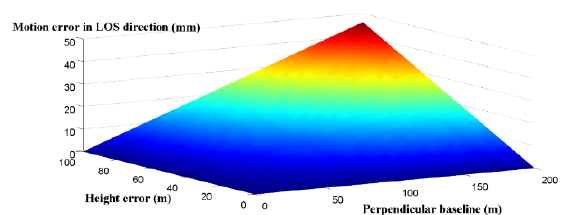
Figure 1. Motion error represented as a function of the perpendicular baseline length and the height error for the case of TSX system For the case of TSX system with the nominal imaging parameters, i.e., q =41 ° , R =662520m, Figure 1 shows the functional relationship of l D , h